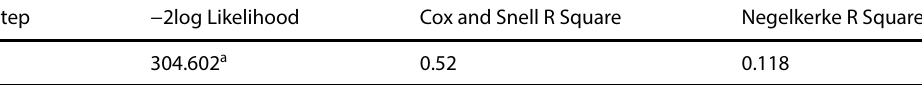
Table 10 Model summary